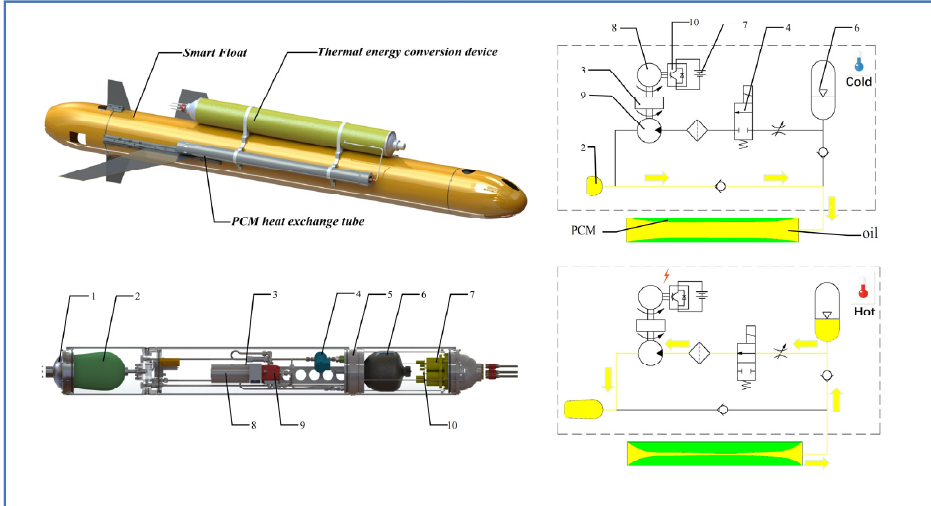
Figure 1. Structure and main parameters of the thermal energy power generation module. The module mainly includes a thermal energy conversion device and PCM heat exchange tube. Schematics of the thermal conversion device: ( 1 ) end cover, ( 2 ) leather bag, ( 3 ) speed increaser, ( 4 ) solenoid valve, ( 5 ) stiffening ring, ( 6 ) accumulator, ( 7 ) battery pack, ( 8 ) generator, ( 9 ) hydraulic motor, and ( 10 ) circuit board.